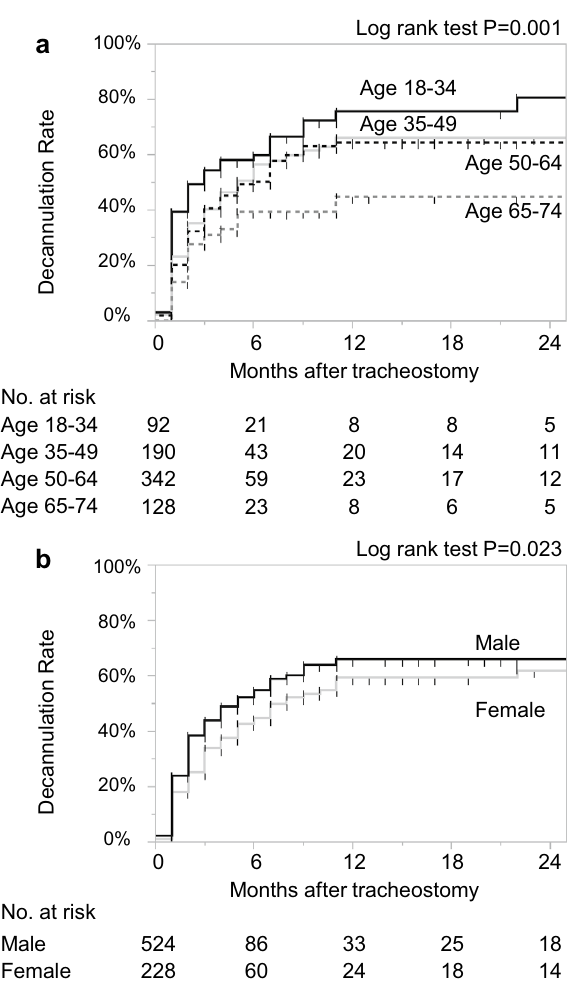
Figure 3. Kaplan–Meier curves for time to decannulation by ( a ) age and ( b )